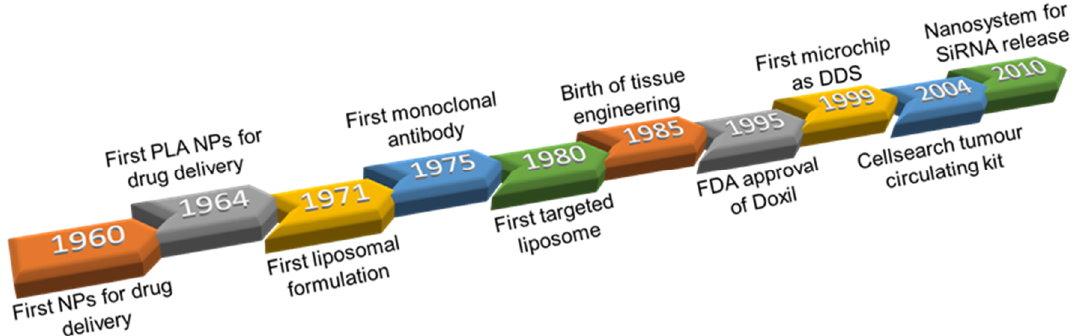
Figure 1. Major discoveries made in the field of nanomedicine, which are linked to the evolution of high-resolution microscopy.